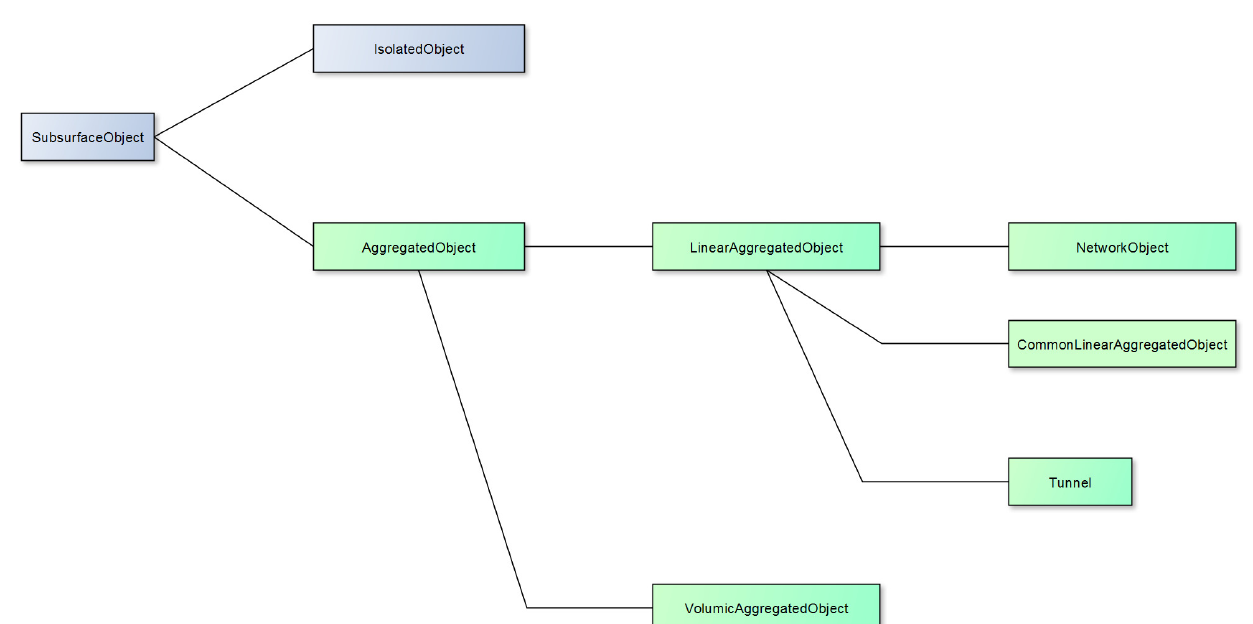
Figure 2. Minimal model focused on simplified geometric representation.